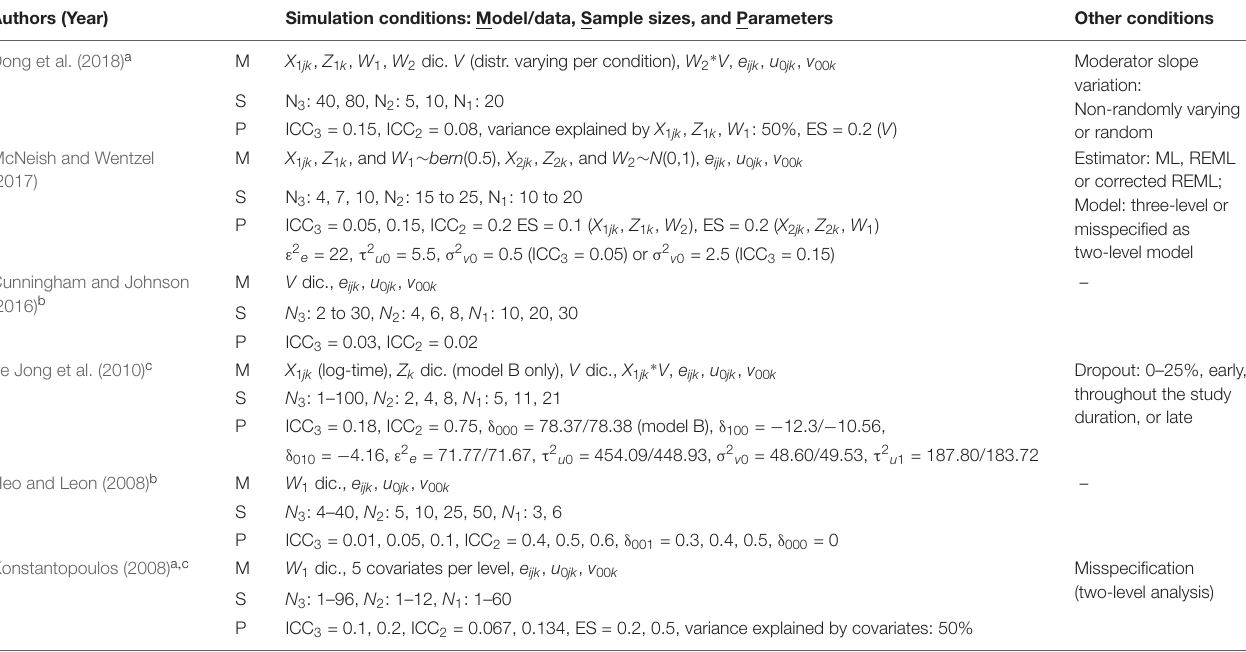
TABLE 2 | Investigated parameters of studies examining the impact of sample sizes on estimation results in three-level models. Simulation conditions: Model/data, Sample sizes, and Parameters Other conditions